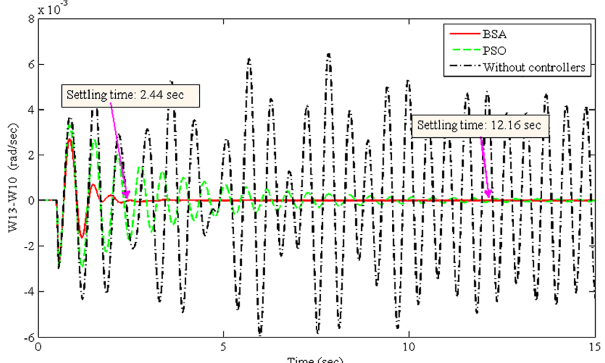
Fig 9. Local mode in area 5 between G13 and G10 (W13-W10) for the 3-phase fault at bus